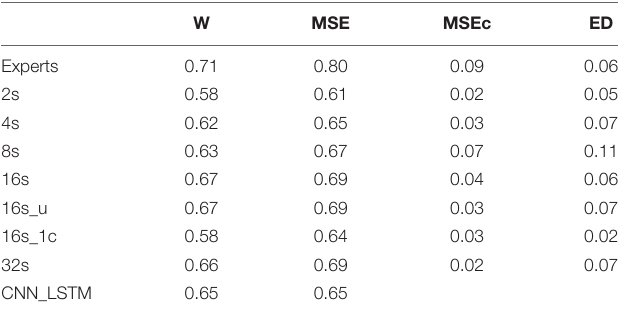
TABLE 3 | Cohen’s kappa computed on the validation dataset ( n = 12) using different network architectures. W MSE